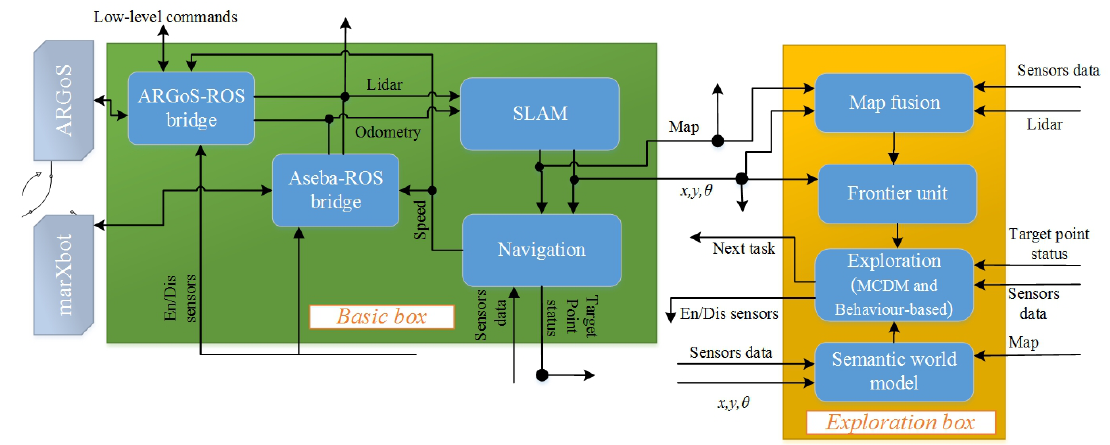
Figure 3. The architecture of the autonomous exploration system for the rescue